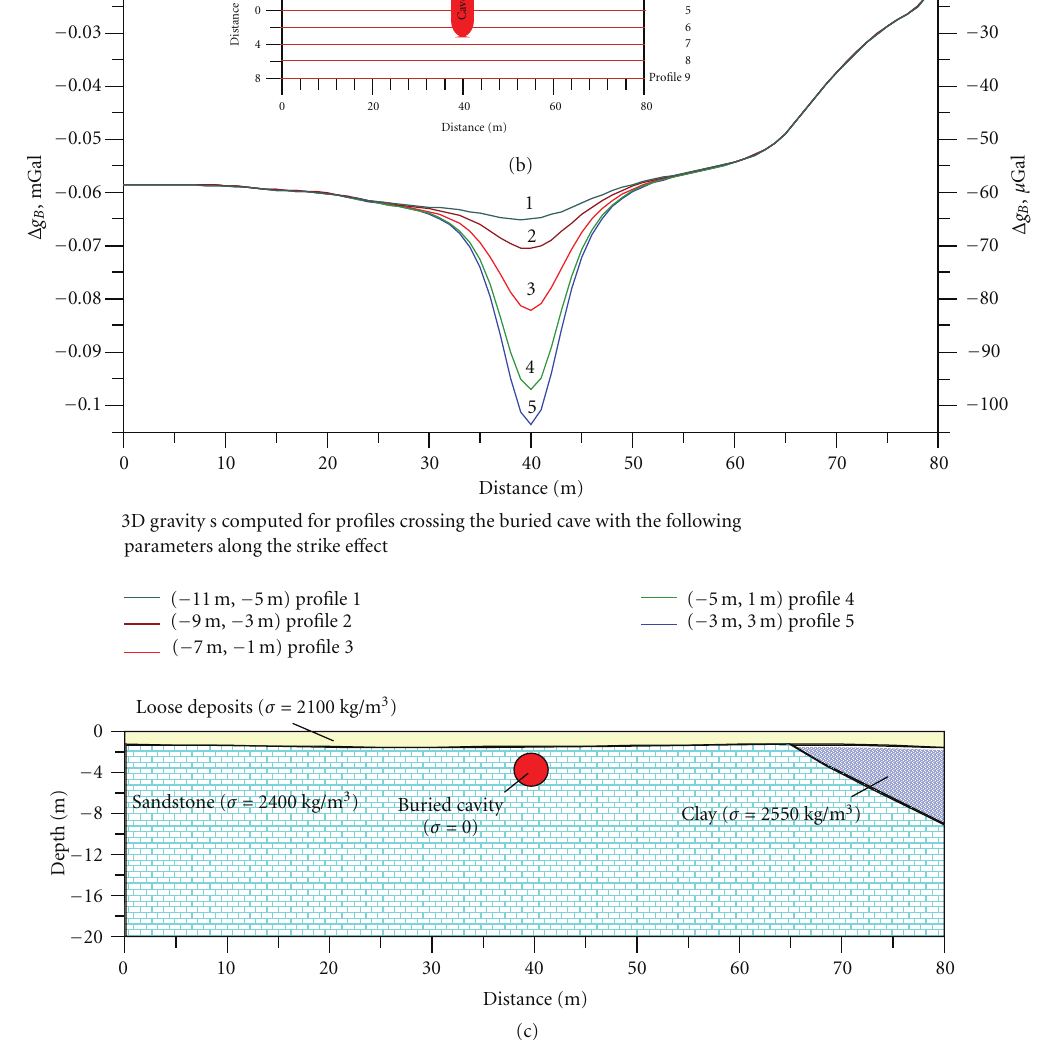
Figure 6: Physical-geological model of buried prehistoric cave and computed 3D gravity anomalies. (a) location of projected profiles and disposition of buried cave (view over), (b) 3D computed gravity e ff ects along profiles 1–5, (c) geological-archaeological sequence.